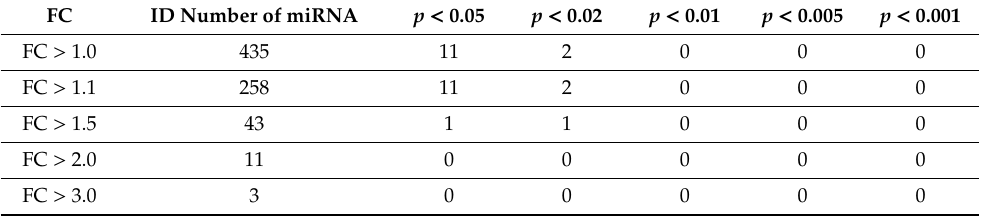
Table 1. Number of miRNA di ff erentiating control group (normal tissue) vs. research group (cancer tissue) transcriptomes; asymptotic p -value determined with Mann–Whitney nonparametric test.